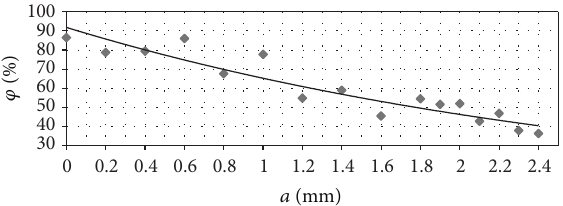
Figure 15: Fiber content in dependence of the distance to the edge of the joining